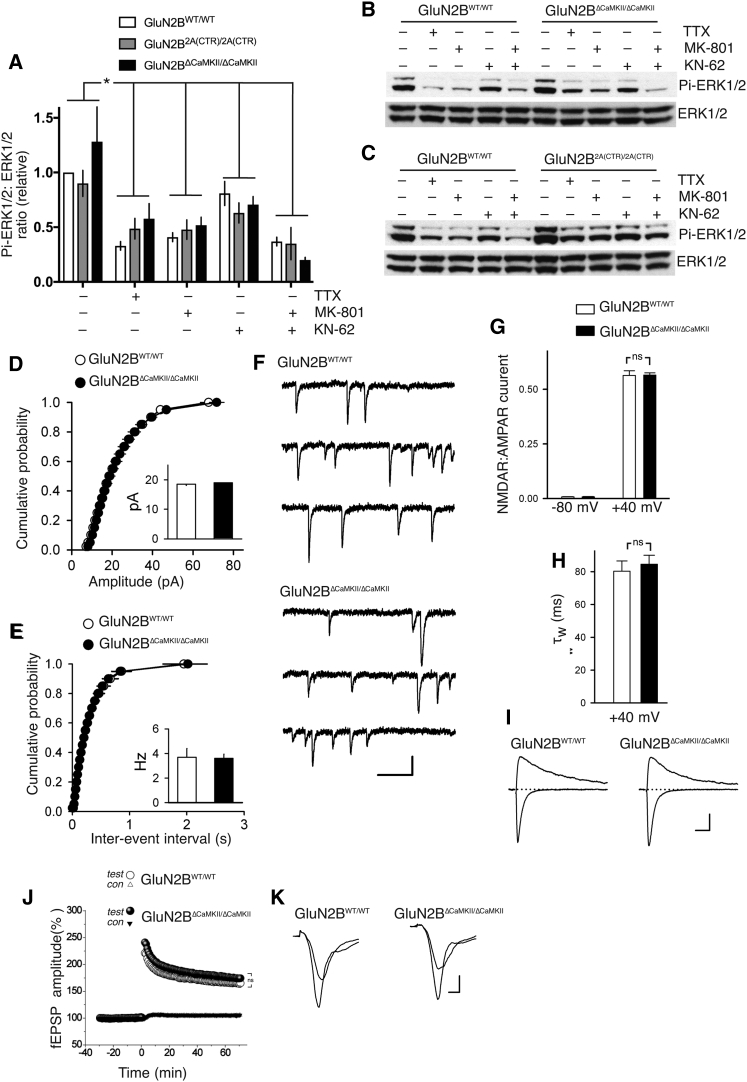
The GluN2B CaMKII Binding Site Is Dispensable for Theta Burst LTP(A–C) Activity-dependent signaling to ERK1/2 does not require GluN2B CTD-specific sequences. DIV9 cortical neurons of the indicated genotypes were treated with TTX (500 nM), KN-62 (10 μM), or MK-801 (10 μM) for 1 hr, after which protein extracts were made and subjected to western blot analysis for phospho-ERK1/2 levels, normalized to total ERK1/2. (A) shows quantitation and (B) and (C) show example blots.∗p < 0.05 two-way ANOVA plus Dunnett’s post hoc test. No genotype-dependent effects were observed (p = 0.39) or genotype-drug interactions (p = 0.16; n = 8 GluN2BWT/WT; n = 4 GluN2BΔCaMKII/ΔCaMKII; n = 4 GluN2B2A(CTR)/2A(CTR)).(D–F) Cumulative probability plots show amplitude (D) and frequency (E) of miniature EPSCs in GluN2BWT/WT and GluN2BΔCaMKII/ΔCaMKII slices. Results are from 11 cells from 3 GluN2BWT/WT mice and 13 cells from 3 GluN2BΔCaMKII/ΔCaMKII mice; p = 0.75 (amplitude); p = 0.94 (frequency); unpaired t test. (F) shows example traces. Scale bar: 10 pA/100 ms.(G) NMDAR:AMPAR EPSC ratios at −80 and +40 mV was measured in GluN2BWT/WT (n = 25; 4 mice) and GluN2BΔCaMKII/ΔCaMKII (n = 30; 4 mice) neurons (unpaired t test; p = 0.95).(H) Weighted time constant (τw) for the decay of EPSCs recorded in (A) at +40 mV was determined using double exponential fits (unpaired t test; p = 0.63).(I) Example traces. Scale bar: 100 pA/20 ms.(J and K) Theta-burst stimulation elicited pathway-specific LTP of synaptic transmission in hippocampal CA1 area. Normalized magnitude of this potentiation 60–65 min after LTP induction did not differ significantly in GluN2BWT/WT mice (29 slices; n = 9) compared to GluN2BΔCaMKII/ΔCaMKII (35 slices; n = 11); p = 0.162 (two-way nested ANOVA). (J) shows quantitation of data and (K) shows example traces before and after LTP induction.(K) Traces show example fEPSP traces immediately before and 1 hr after theta-burst stimulation. Scale bar: 0.5 mV/2 ms.